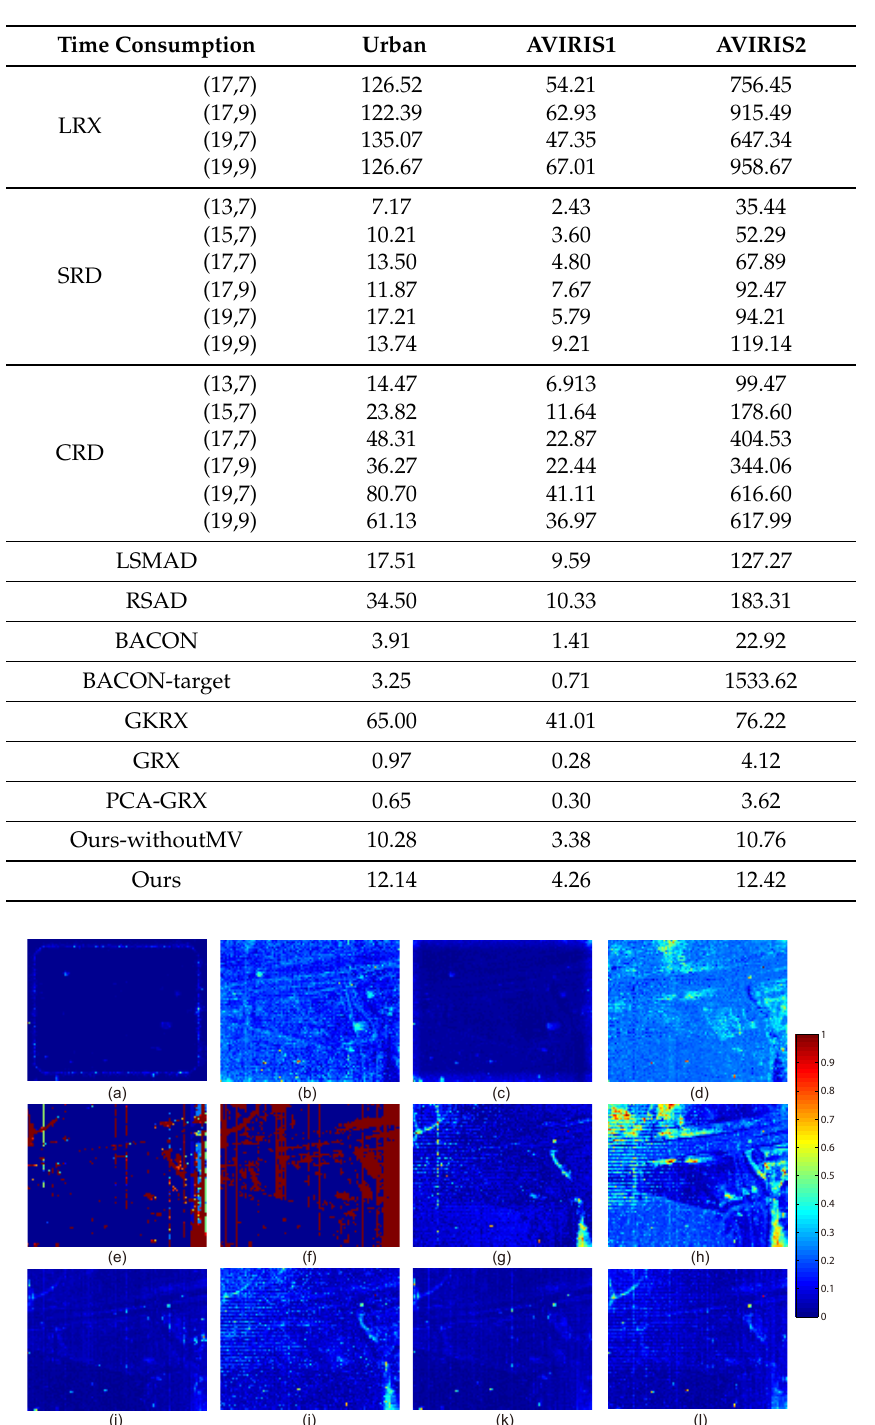
Figure 2. The visualization results of different detectors on Urban data set. ( a ) LRX: window size (19,7); ( b ) SRD: window size (13,7); ( c ) CRD: window size (13,7); ( d ) LSMAD; ( e ) RSAD; ( f ) BACON; ( g ) BACON-target; ( h ) GKRX; ( i ) GRX; ( j ) PCA-GRX; ( k ) Ours-withoutMV; ( l ) Ours. Values in the color bar represent the anomaly